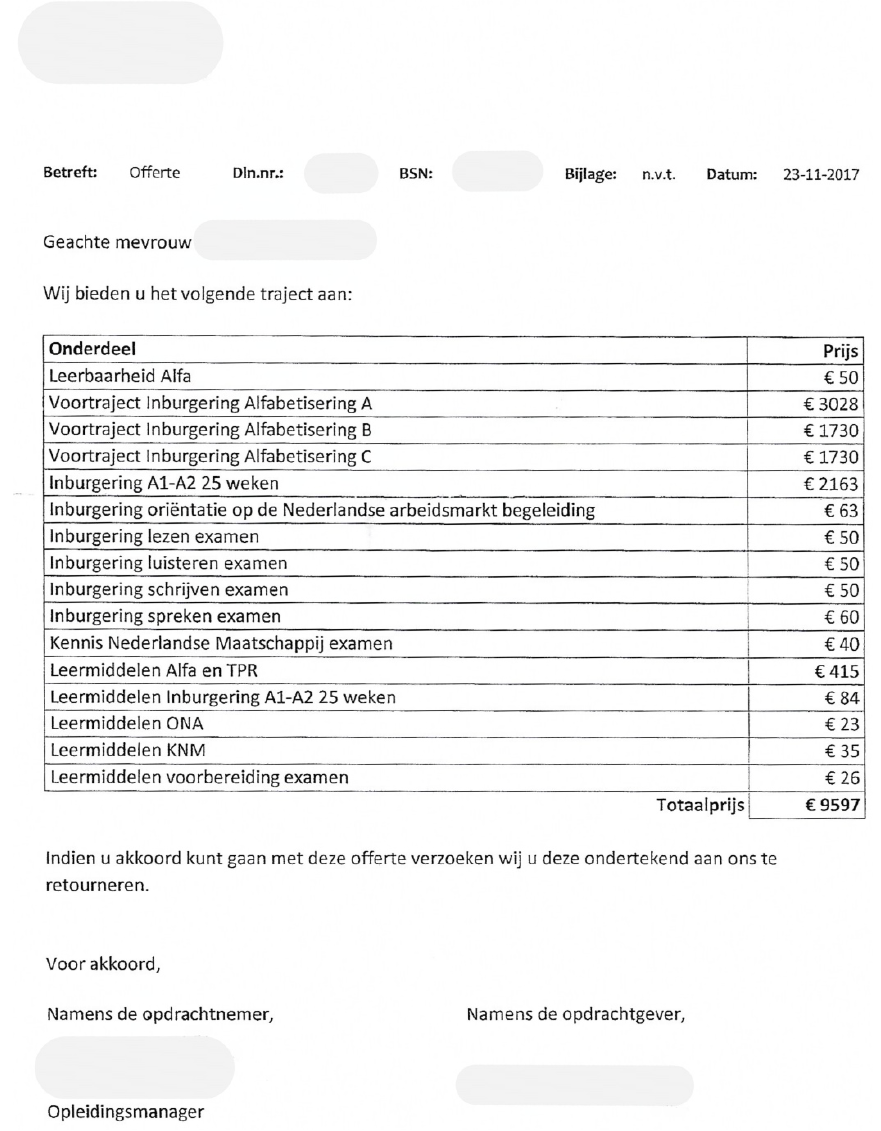
Figure 2. Copy of an original offer for a licensed language school, sent to an asylum seeker who lives in Kerkrade. Urban Planning, 2018, Volume 3, Issue 4, Pages